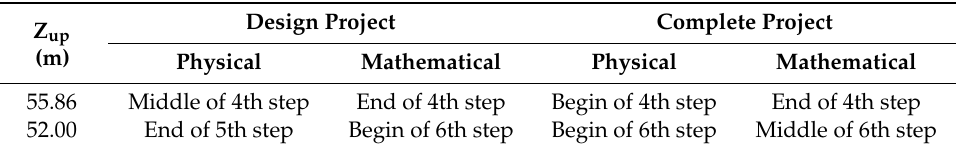
Figure 15. Steady hydraulic jump when Z up = 52 m in the complete case [16]. Table 6. Location of hydraulic jump.